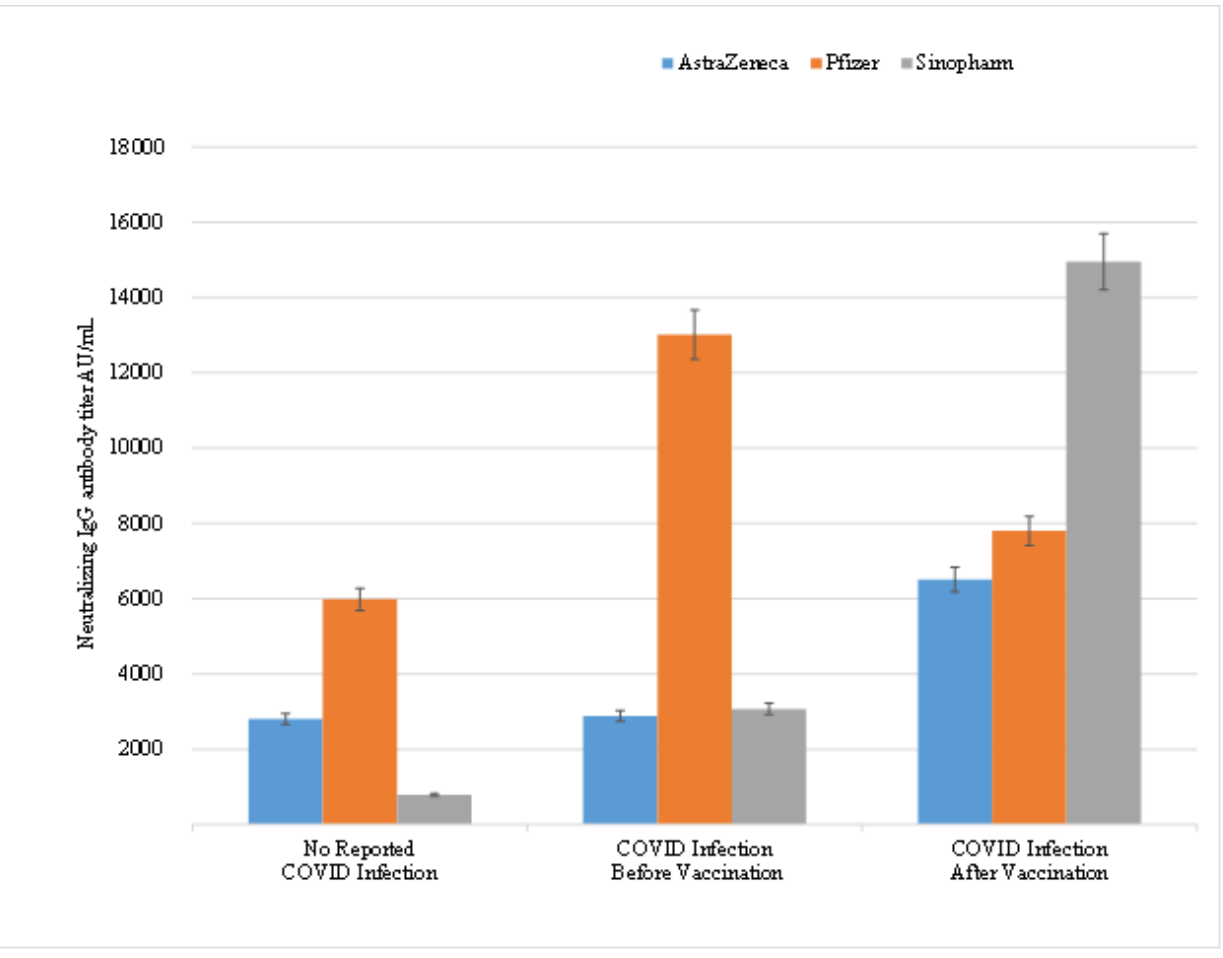
Figure 1. Correlation between the times of acquiring COVID-19 infection on the mean titer levels of neutralizing IgG antibodies in HCWs.